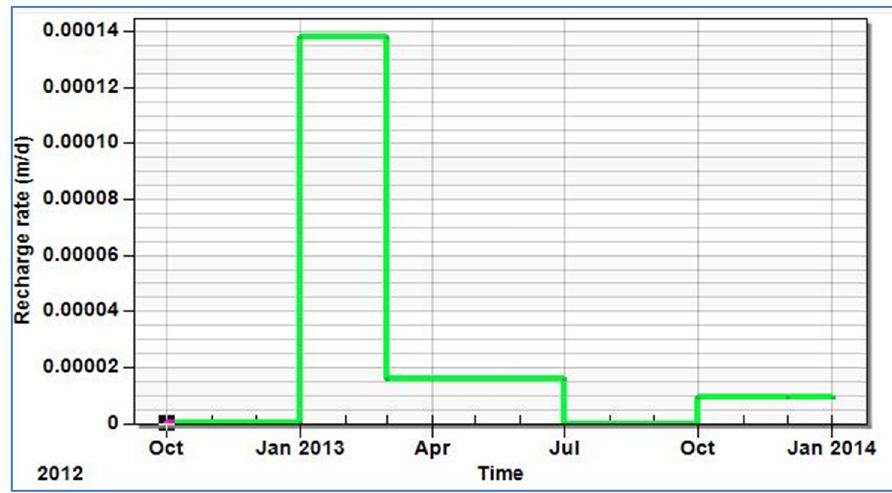
Figure 8: Transient recharge rate.